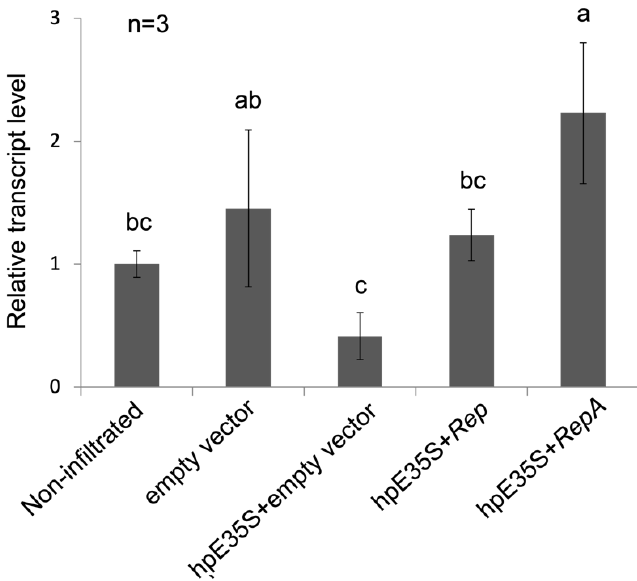
Figure 4. Expression level of GFP nascent RNA. Samples were prepared by pooling tissues from ten leaves. qPCR data were analyzed using the ΔΔCq method and internally normalized to RubisCo transcript level. The letters indicate statistically significant difference as determined by one-way ANOVA among multiple groups, followed by Tukey’s post hoc test.